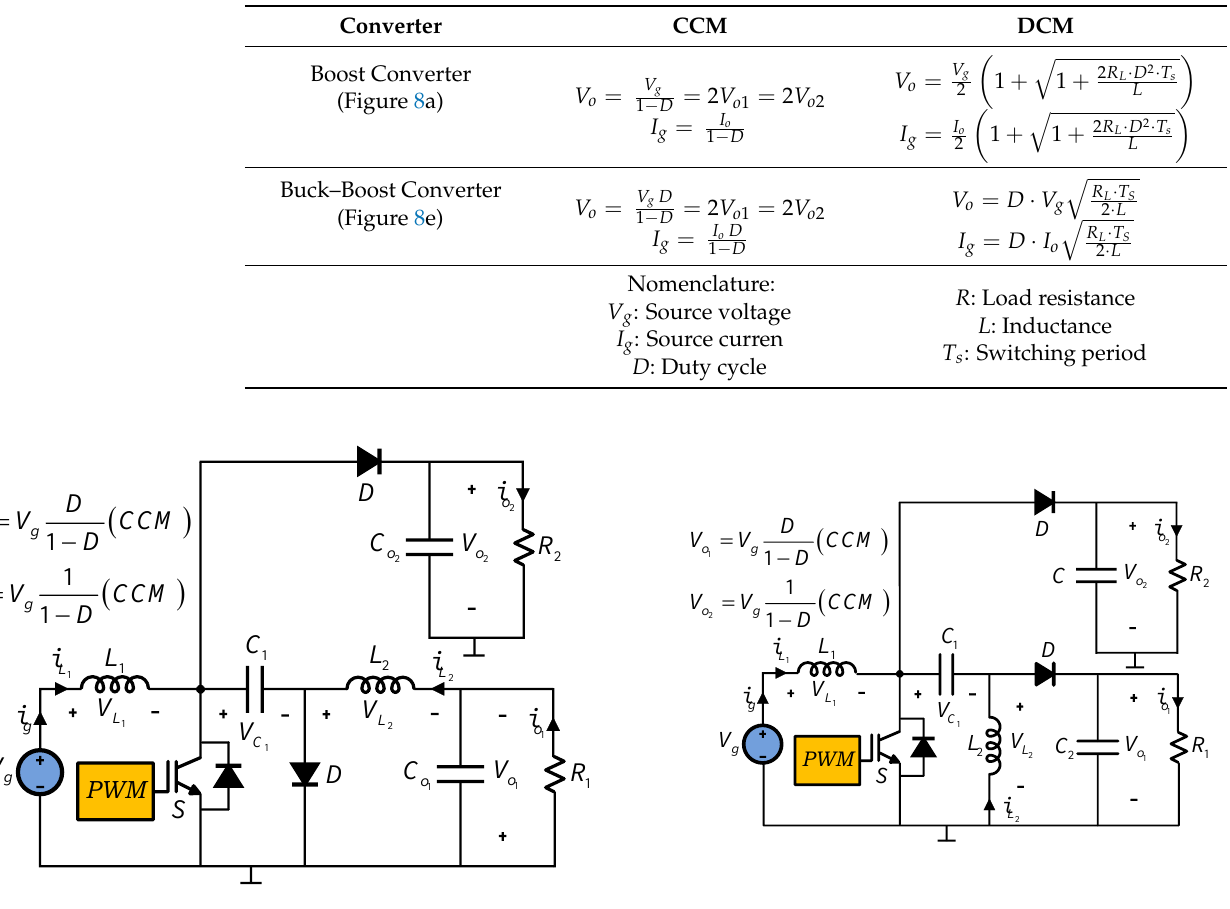
Table 5. Conversion relations for SIDO DC–DC Converters.